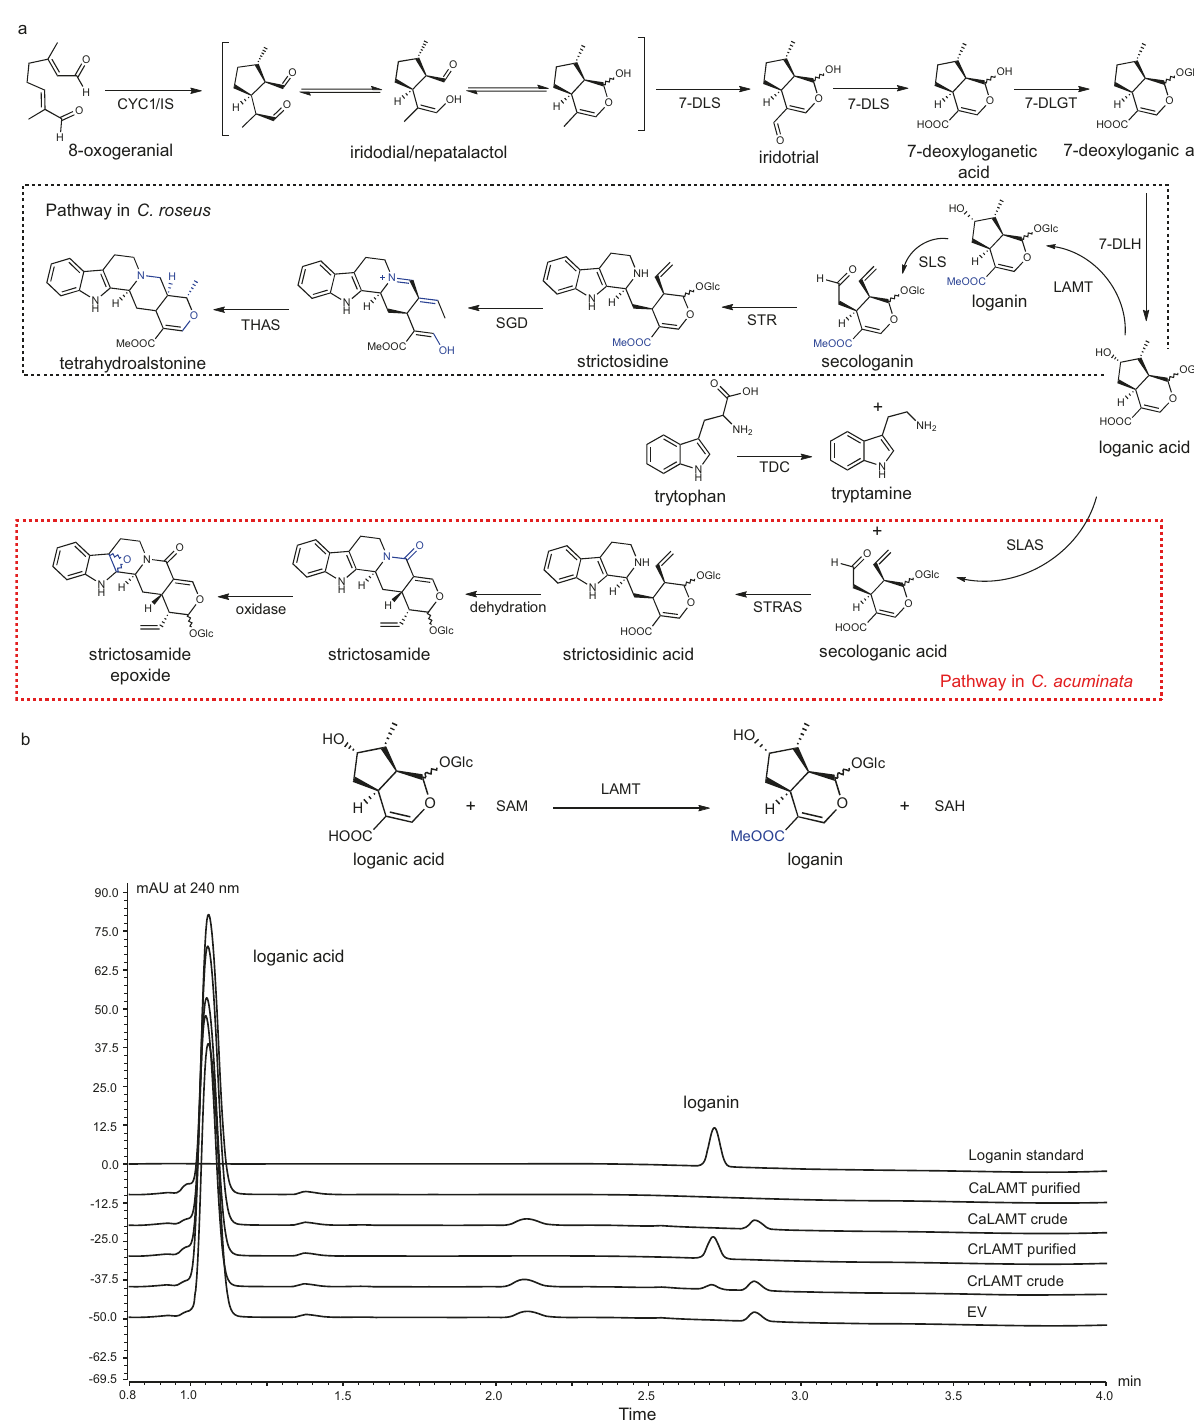
Fig. 3 Comparison of camptothecin and vinblastine/vincristine biosynthesis pathways. a Chemical representation of the iridoid pathway in C. roseus and C. acuminata . Different modi fi cations resulting from reaction steps in the two species are indicated in blue. The camptothecin biosynthesis pathway in C. acuminata is outlined by the red-dotted box. b UPLC traces illustrate representative compound peaks for the target products of CaLAMT and